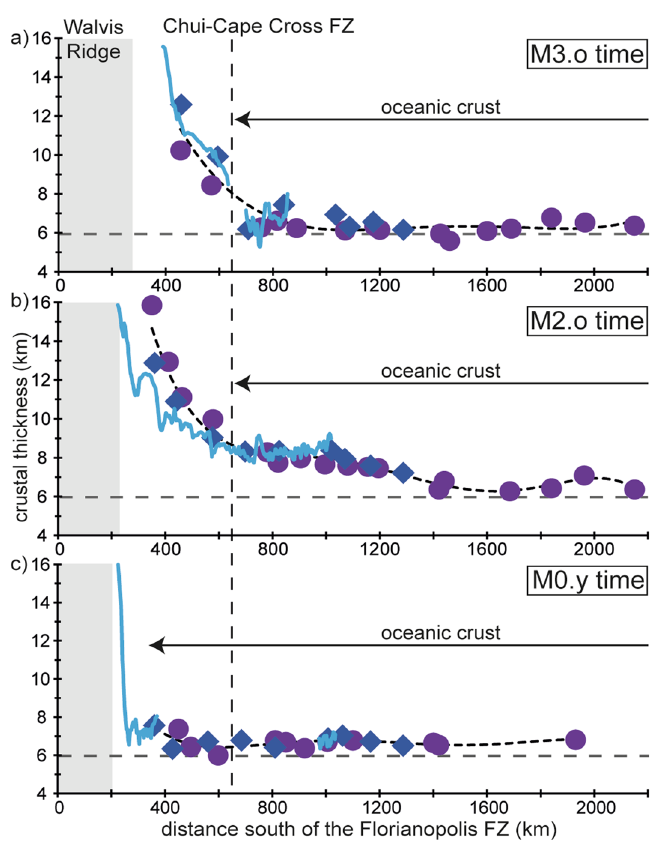
Figure 7. Crustal thickness variation along M0.y, M2.o and M3.o isochrones alongside both conjugated margins with respect to the Florianopolis FZ. Purple circles are from the South American plate and dark blue lozenges are from the African plate. Black dashed lines indicate the best polynomial fits. The blue lines show crustal thickness variations from seismic strike lines along the Namibian margin close to the isochrones (< 20 km). The dashed horizontal grey line indicates 6 km crustal thickness. The grey shaded areas correspond to the Walvis ridge width taken from the free air gravity anomaly map derived from satellite altimetry